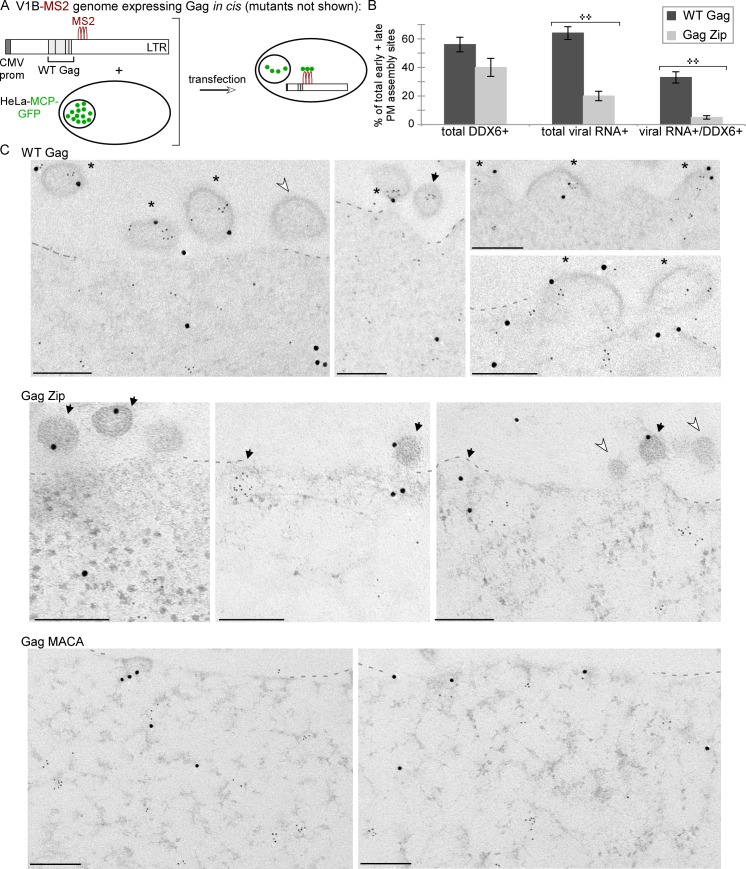
The association of DDX6 with unspliced viral RNA is observed in situ at PM assembly sites for WT Gag but not for Gag Zip.(A) HeLa cells expressing MCP-GFP were transfected with V1B genomes that contain MS2 binding sites (Set IV constructs in Fig 1A) and express WT Gag (shown), Gag Zip, or MACA. Cells were analyzed by double-label IEM, using αDDX6 and αGFP, which allowed detection of DDX6 (large gold) and MCP-GFP-labeled unspliced viral RNA (small gold), respectively. All early and late assembly sites at the PM were identified in ten cells (~250 μm of PM total per group), and scored for labeling of unspliced viral RNA, DDX6, and double labeling. (B) Graph shows the percentage of all early and late PM assembly events that display DDX6 labeling (total DDX6+), labeling of unspliced viral RNA (total viral RNA +), or double labeling (viral RNA+/DDX6+). (C) Images show representative assembly sites at the PM for each group, with symbols indicating early or late PM assembly sites that are single-labeled for either unspliced viral RNA or DDX6 (dark arrows), double-labeled (asterisks), or unlabeled (open arrows). Dotted lines outline the PM. Scale bars, 200 nm. Error bars show SEM (n = 10 cells). ++ indicates a significant difference between WT Gag and Gag Zip (p<0.005). For additional data, see S1 Table.